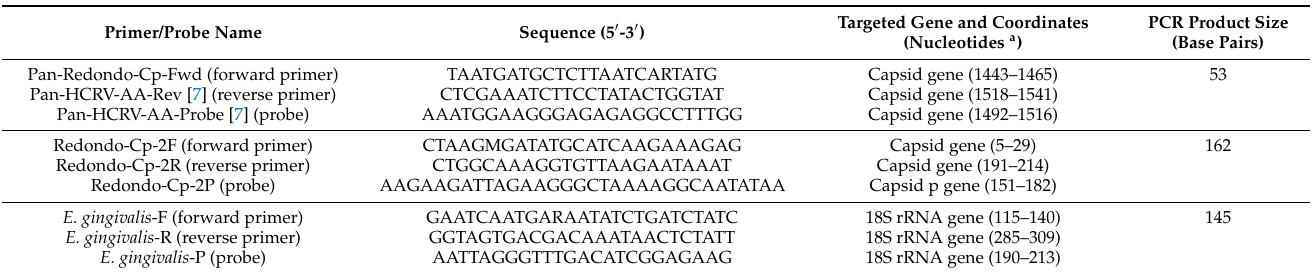
Table 3. Primer and probe sequences used for redondovirus and E. gingivalis DNA detection using real-time